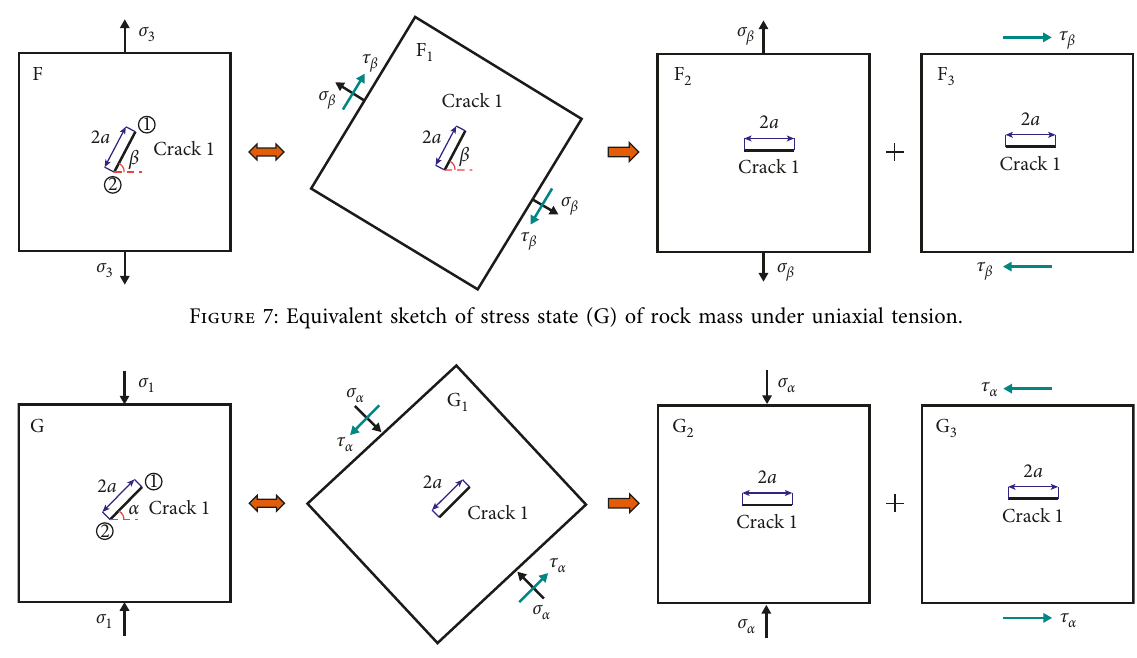
Figure 8: Equivalent sketch of stress state (F) of rock mass under uniaxial